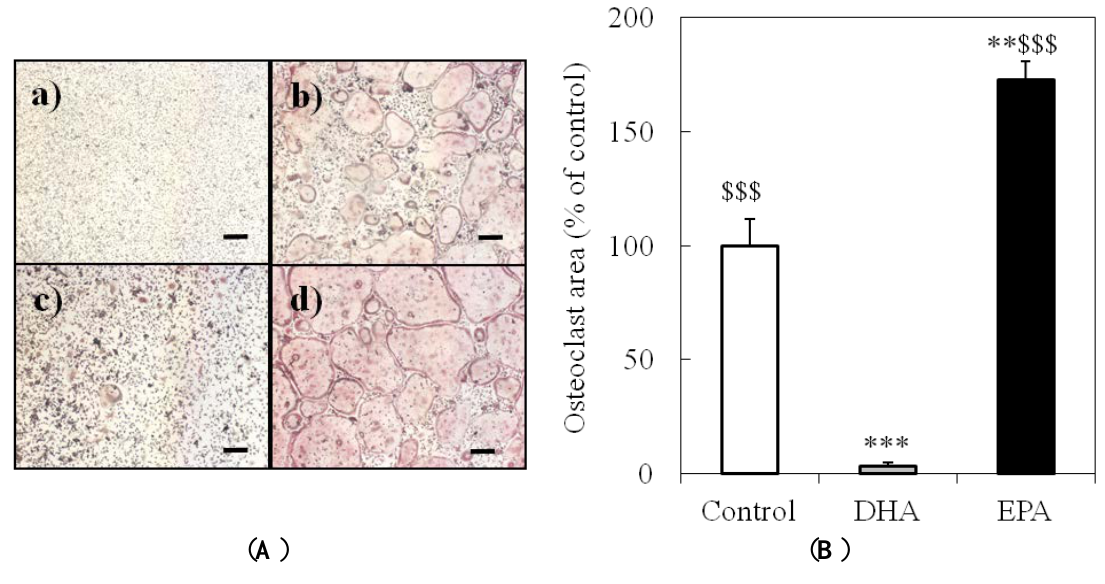
Figure 3. Effect of docosahexaenoic acid (DHA) and eicosapentaenoic acid (EPA) on sRANKL-induced osteoclastogenesis in bone marrow macrophages (BMMs). ( A ) Representative image of osteoclasts. BMMs were cultured without ( a ) or with ( b – d ) sRANKL in the presence of 10 μm DHA ( c ) or 10 μm EPA ( d ). Cells were stained for tartrate-resistant acid phosphatase (TRAP) after a 96 h culture. The scale bar indicates 200 μm. ( B ) The areas occupied by osteoclasts (TRAP + cells with three or more nuclei) were analyzed. Each column and bar represents the mean ± SE of four or five wells. * Significantly different from the control (sRANKL(+)) (** p < 0.01, *** p < 0.001) by Tukey-Kramer’s multiple comparison test. $$$ Significantly different from the